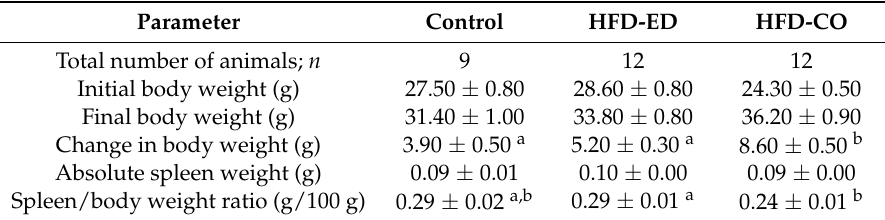
Table 2. Changes in body weight composition and plasma lipid